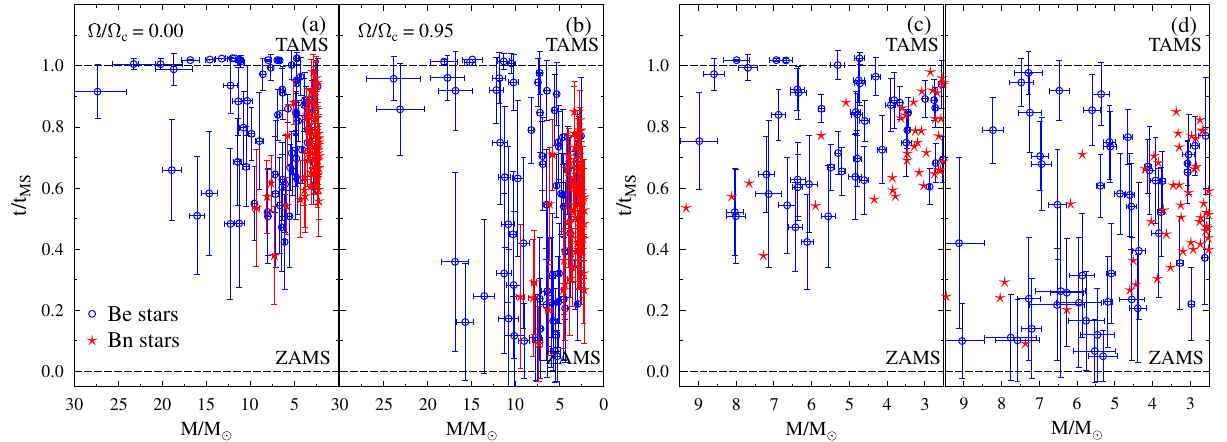
Figure 38. Fractional age t / t MS vs. stellar mass M / M (cid:12) not treated for rotation (panels a , c ), and using the parameters corrected for rotational effects (panels b , d ). Panels c and d are the zooms of a and b for masses M / M (cid:12) < 10, respectively. Error bars indicate uncertainties affecting the t / t MS and M / M (cid:12) determinations. Adapted from Cochetti et al.